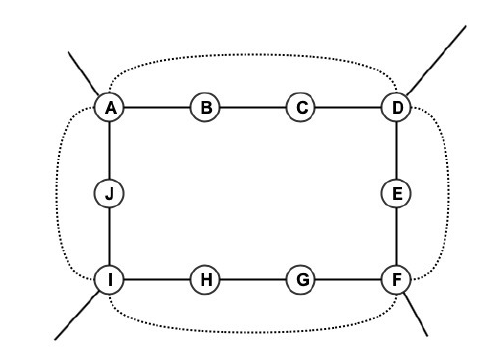
Figure 2. A small example of the superlinks for the pipes in a looped WDS (dotted lines are